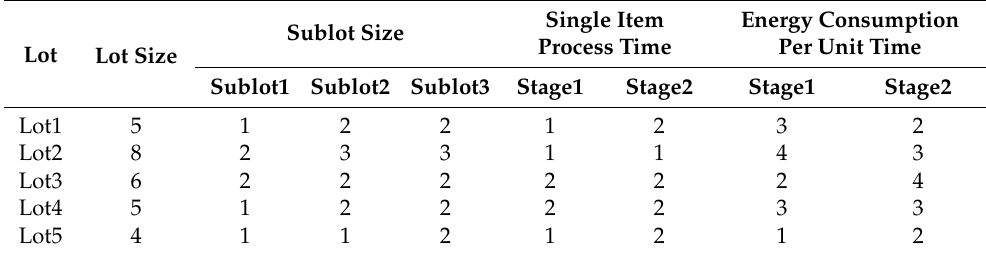
Table 1. Illustrative example of HFSP_ECS.